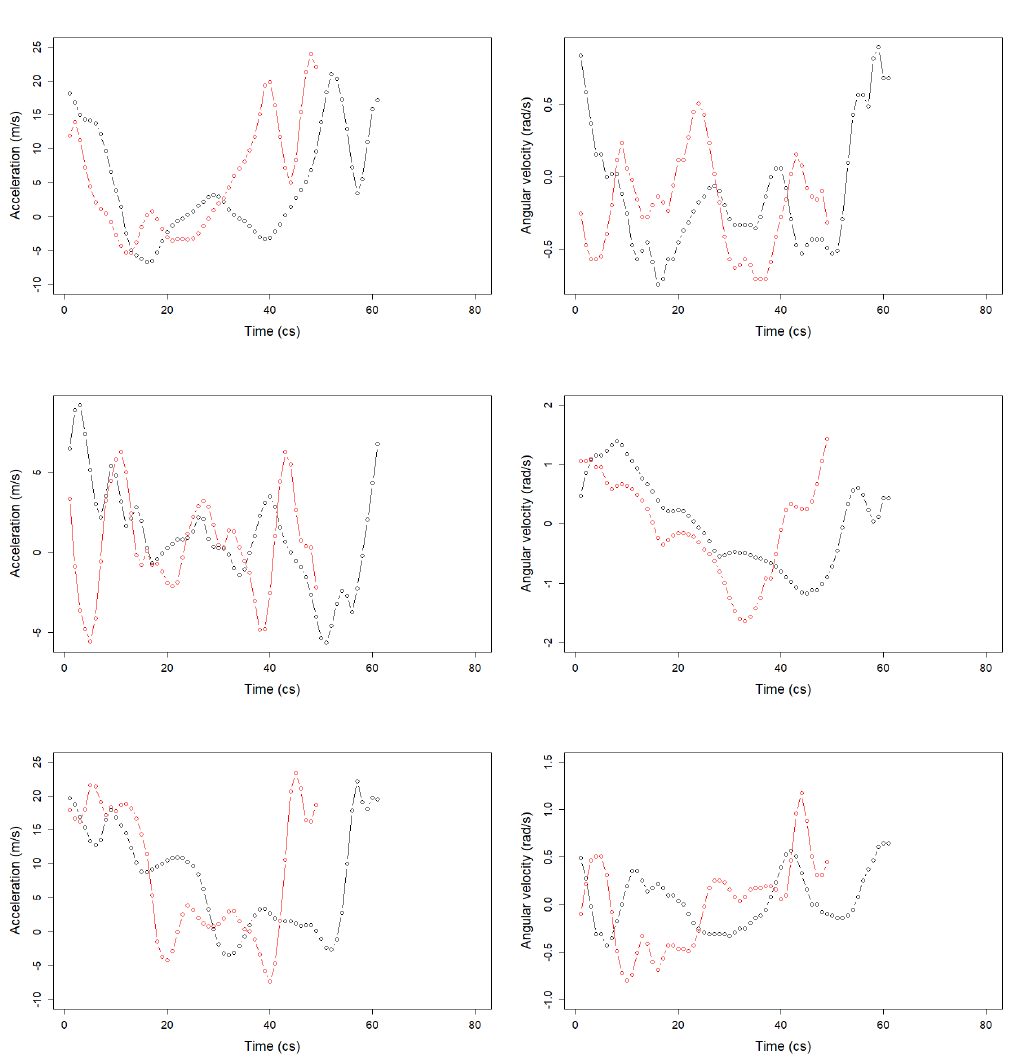
Figure 4. One stride acceleration ( left ) and angular velocity ( right ) signals for the x -axis ( top ), y -axis ( middle ), and z -axis ( bottom ). The red curve corresponds to a running speed of 8.6 m/s, and the black one corresponds to a running speed of 5.0